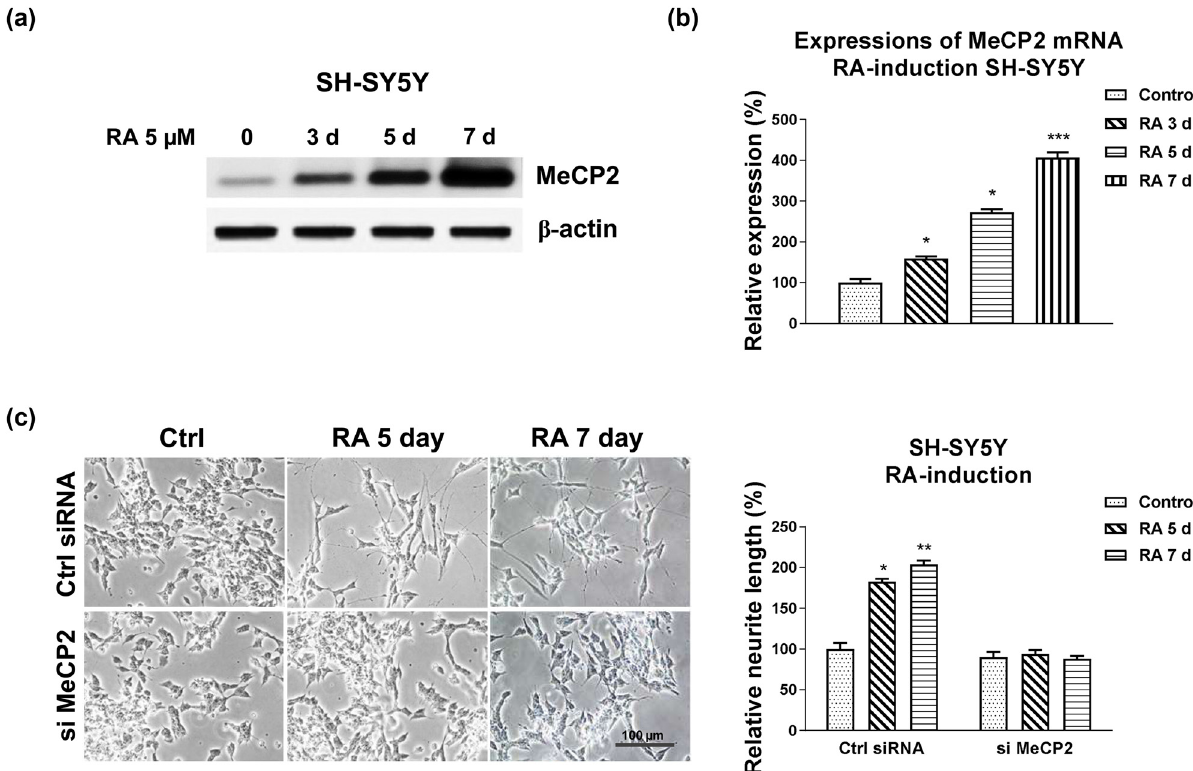
Figure 4: Roles of MeCP2 in the RA - induced neuron di ff erentiation. ( a ) SH - SY5Y cells were treated with 5 µM RA for 3, 5, and 7 days. Protein and ( b ) mRNA expressions of MeCP2 were detected. ( c ) SH - SY5Y cells were transfected with control siRNA or MeCP2 siRNA for 48 h, followed by treatments with 5 µM RA for 5 and 7 days. Cell morphologies were examined under a microscope, and the neurite length was measured. * p < 0.05; ** p < 0.01; and *** p <